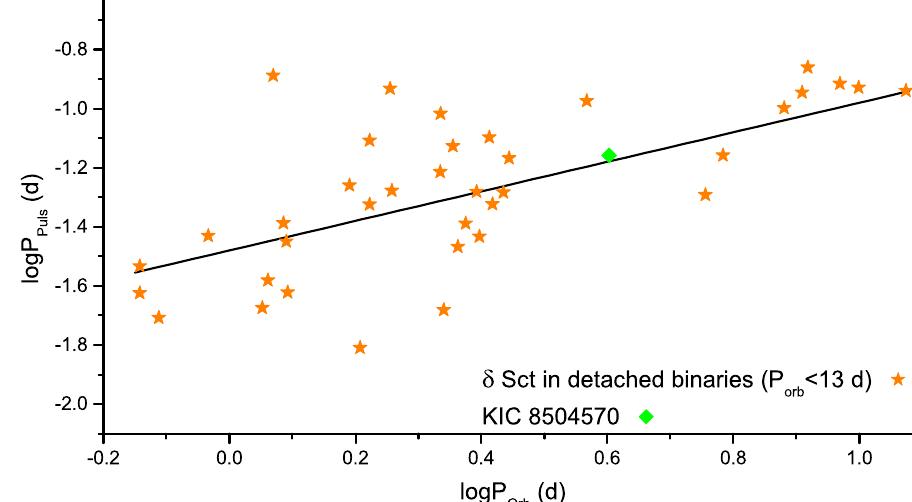
Figure 10. Location of the oscillating (primary) component of KIC 8504570 among other δ Scuti stars-members of detached systems with P orb < 13 d within the P orb − P pul diagram. Symbols have the same meanings as in Figure 8, while the solid line denotes the empirical linear fit of Liakos [32].